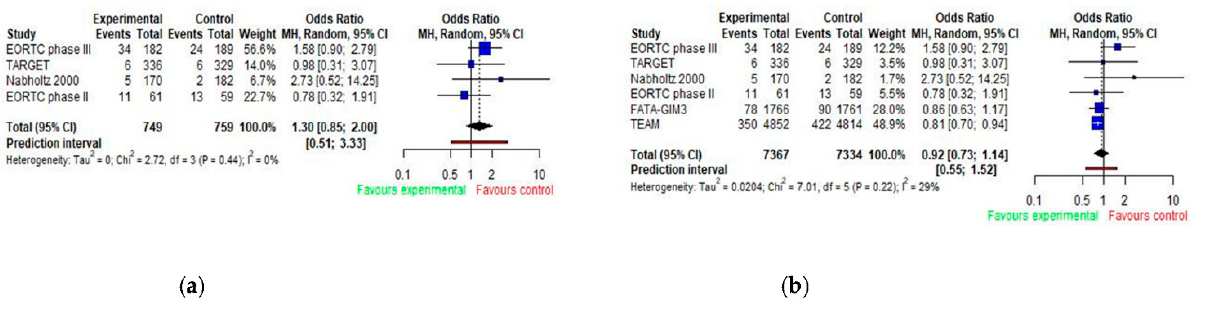
Figure 5. Forest plot of odds ratios for body weight gain with AIs by trial design ( a , b ). E (experimental group); C (control group). ( a ) E: AIs vs. C: tamoxifen (in monotherapy); ( b ) E: AIs (monotherapy) vs. C: AIs + tamoxifen (sequence) or tamoxifen (monotherapy).